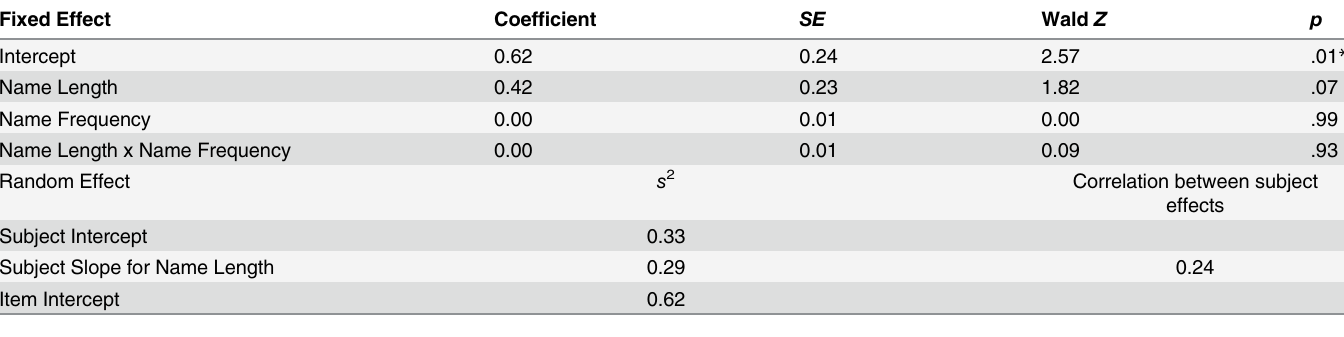
Table 4. Summary of logistic regression predicting the likelihood of a congruent silhouette